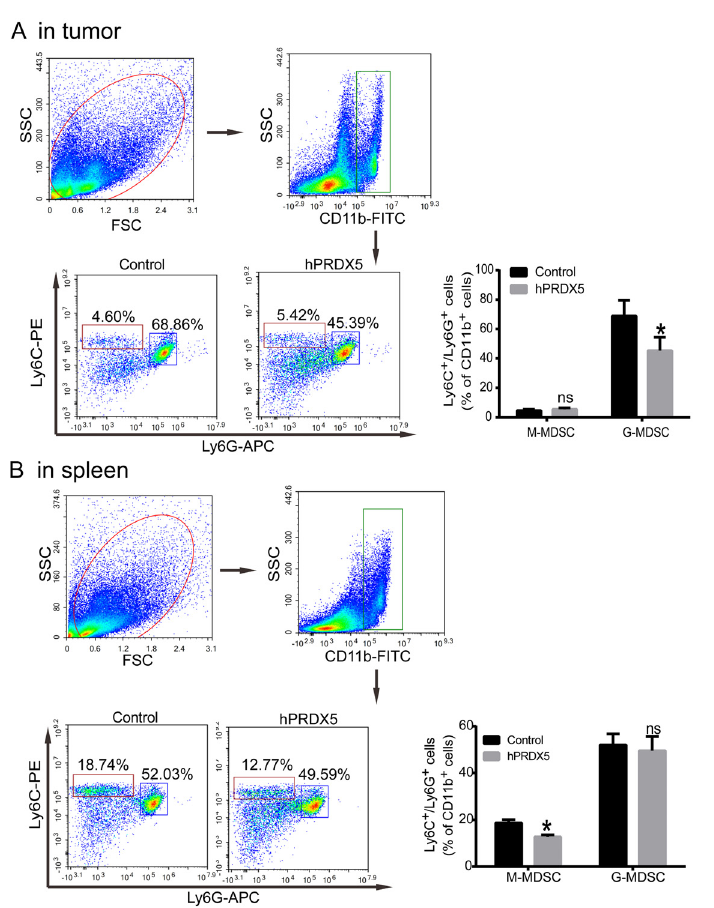
Figure 4. Effect of human peroxiredoxin-5 (hPRDX5) on the proportion of MDSC cells in spleen and tumor tissues of mice. A , Proportion of monocytic myeloid-derived suppressor cells (M-MDSC) cells and granulocytic (G)-MDSC cells in tumor tissues ( A ) and in spleen tissues ( B ) in the control group and the hPRDX5 treatment group. Data are reported as means ± SD. *P o 0.05 compared with the control ( t -test). ns: not signi fi